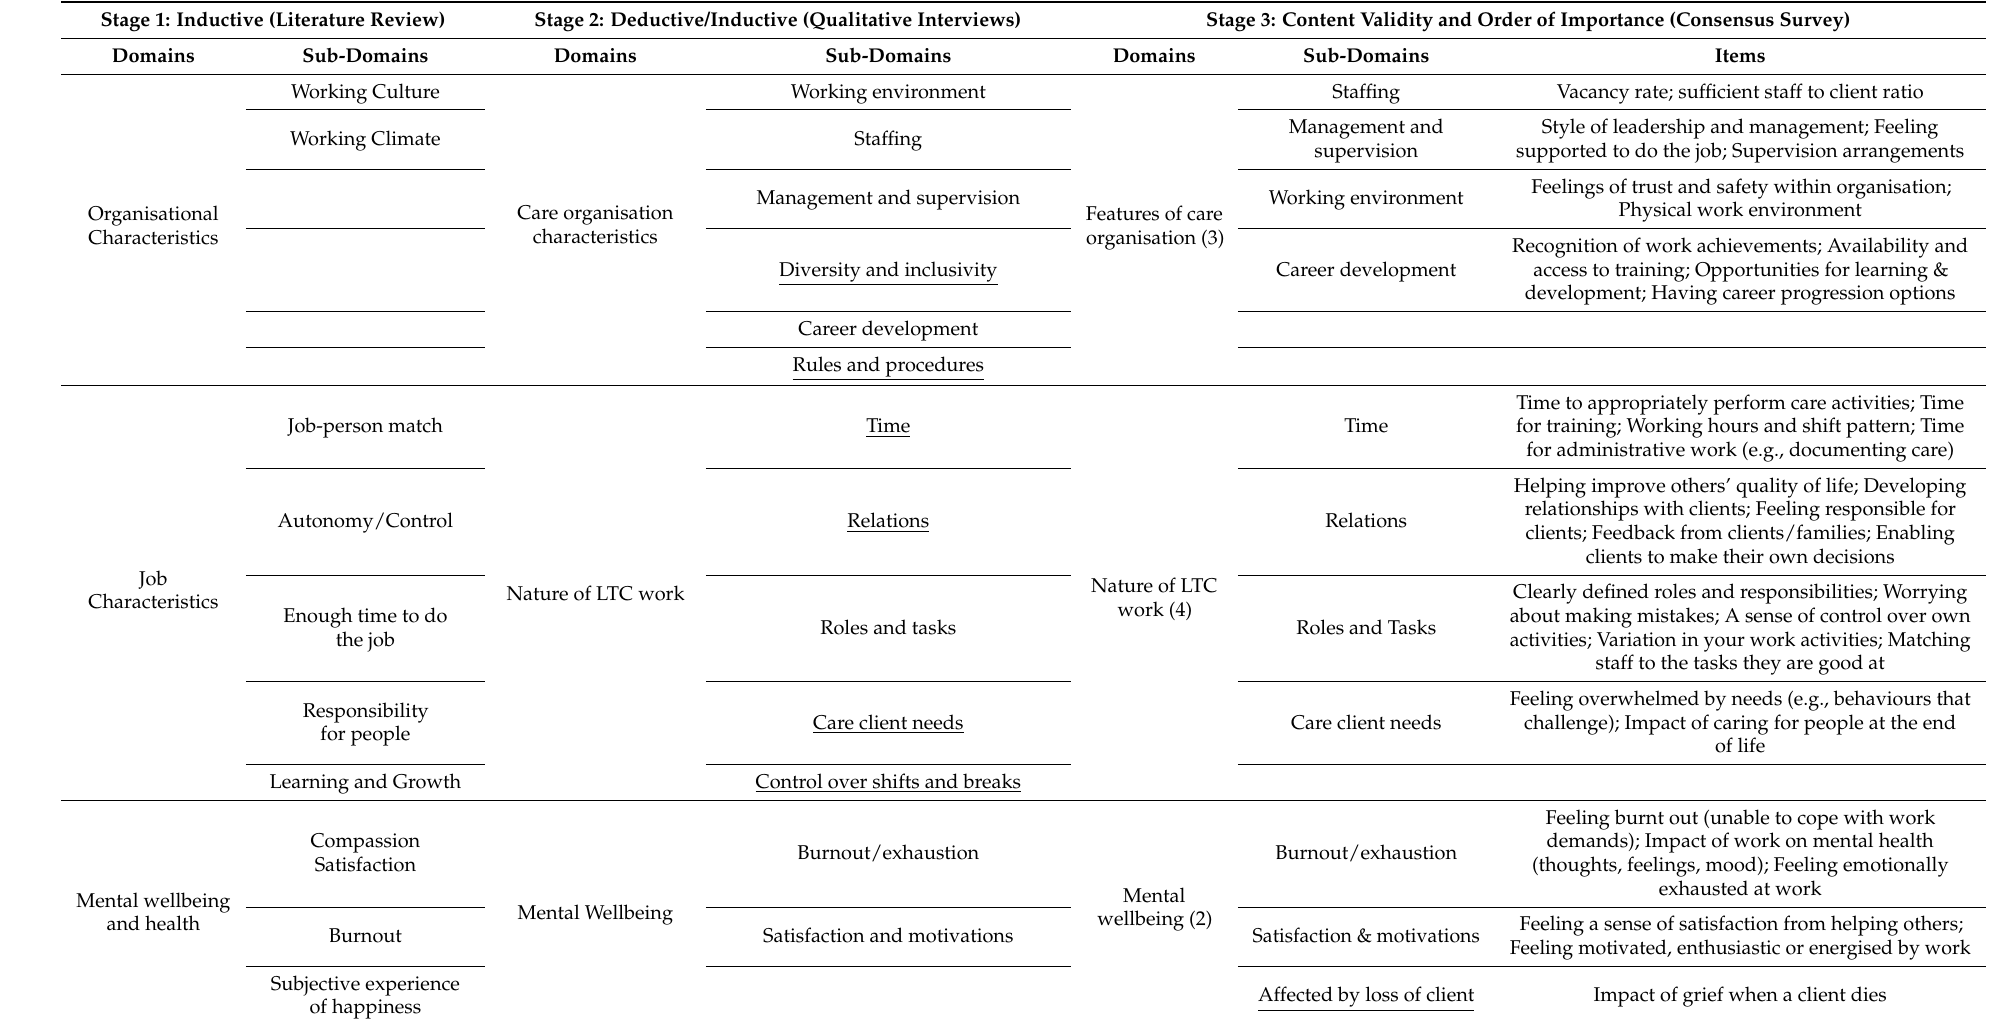
Table 3. Development of the CWRQoL domains, sub-domains and items through the different stages of the